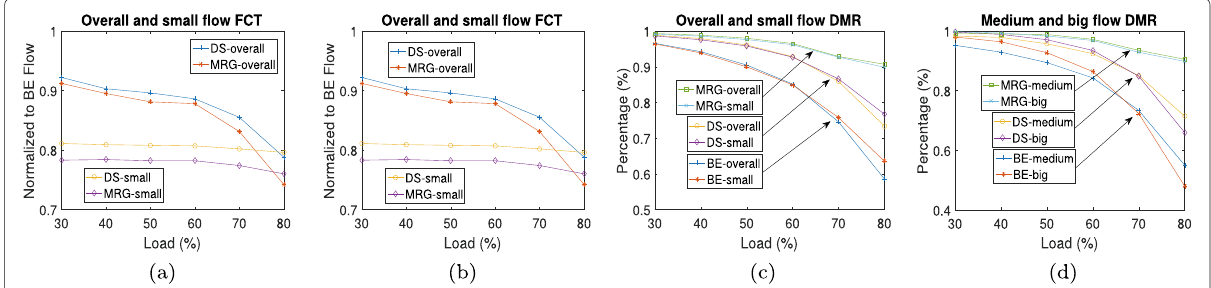
Fig. 10 FBP with Websearch workload ( a ) overall and small flow FCT; ( b ) Medium and big flow FCT; ( c ) Overall and small flow DMR; and ( d ) Medium and big flow